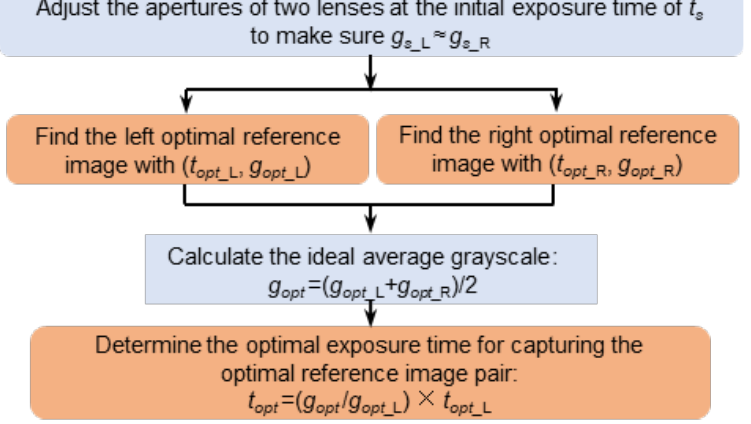
Figure 2. Flow chart showing the automated camera exposure control method for capturing the optimal reference image pair.